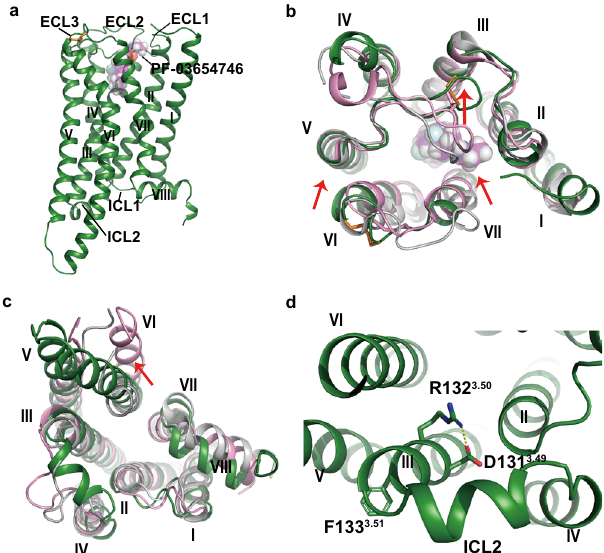
Fig. 1 | Overall structure of H3R – PF-03654746 complex. a Membrane view of H 3 R – PF-03654746 structure. H 3 R was shown in forest green ribbons. PF-03654746 was shown in a magenta sphere. The disul fi de bond was shown as orange sticks. b , c Structural comparison of H 3 R (forest green) with inactive H 1 R (gray, PDB ID: 3RZE) and active H 1 R (pink, PDB ID: 7DFL) from extracellular view ( b ) and intra- cellular view ( c ). d Intracellular view showing a salt-bridge interaction (yellow dashed line) between D131 3.49 and R132 3.50 . The red arrows indicated movements of TMs5/6 and ECL2 in the H 3 R structure compared to the H 1 R inactive structure.